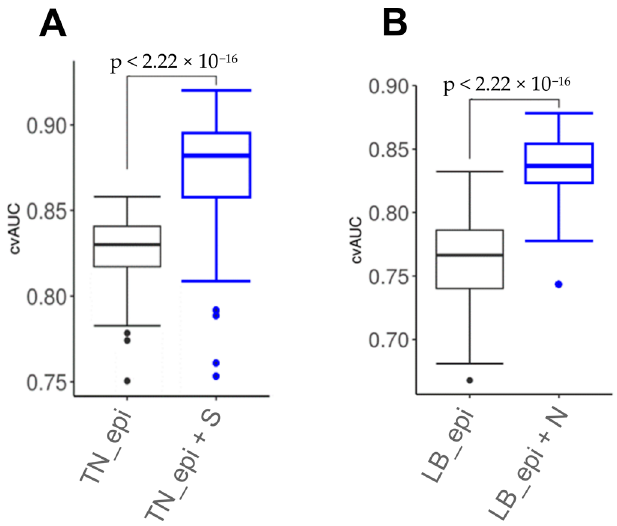
Figure 6. Boxplots for breast cancer NACT sensitivity classifiers, consisting of epigenetic (_epi) and combined epigenetic and clinical predictors (_epi + S, _epi + N) for ( A ) TN and ( B ) luminal B (LB) breast tumors.